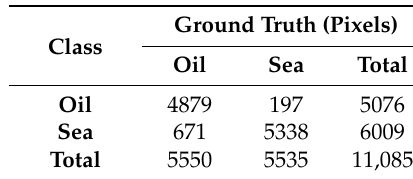
Table 14. Confusion matrix achieved by SVM based on four features derived from ISOMAP on quad-pol SAR features.